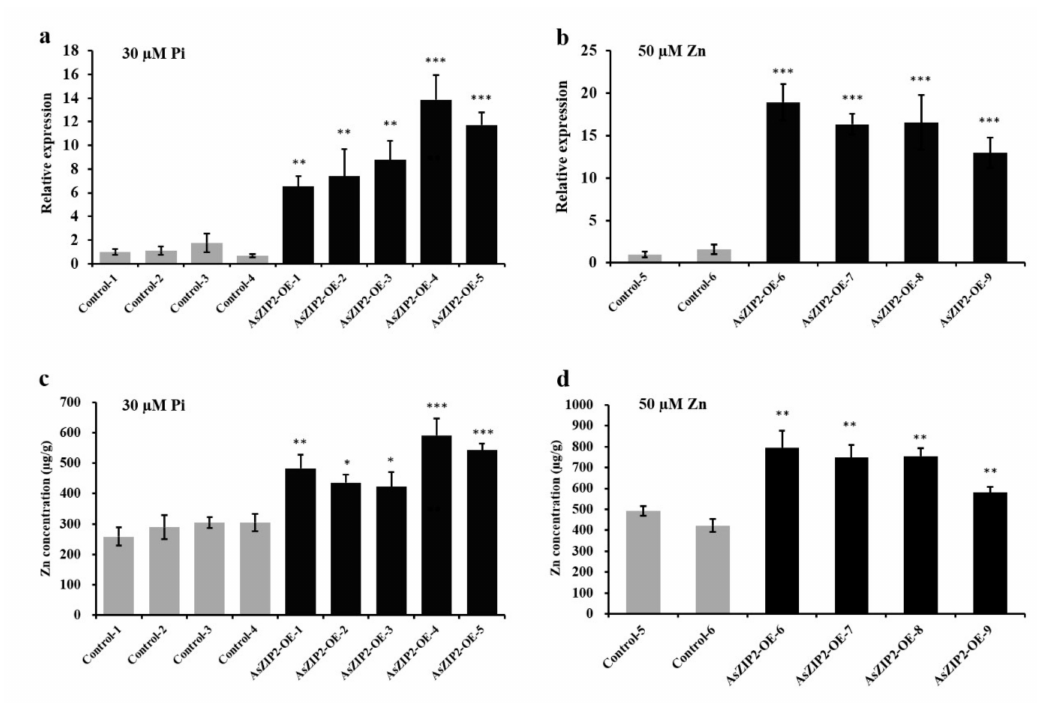
Figure 8. Zinc (Zn) concentration in transgenic A. sinicus lines overexpressing AsZIP2 ( AsZIP2-OE lines) and in control lines grown under Pi starvation or moderately high Zn supply. ( a , b ) Molecular phenotypes in the transgenic A. sinicus roots during Pi starvation (30 µ M) or moderately high Zn (50 µ M ZnCl 2 ) conditions. Real time qRT-PCR analysis of AsZIP2 expression in control and OE lines. AsZIP2-OE-1 to AsZIP2-OE-11 represented independent transgenic lines. AsActin served as the endogenous control. ( c ) The Zn concentrations in the transgenic roots of 56-d-old A. sinicus plants grown in sand cultures exposed to Pi starvation (30 µ M). ( d ) The Zn concentrations in the transgenic roots of 56-d-old A. sinicus plants grown under moderately high Zn concentration (50 µ M ZnCl 2 ). Error bars represent the SD for means of three technical replicates. Significant differences between the AsZIP2-OE lines and controls: ***, p < 0.001; **, p < 0.01; *, p < 0.05; Student’s t